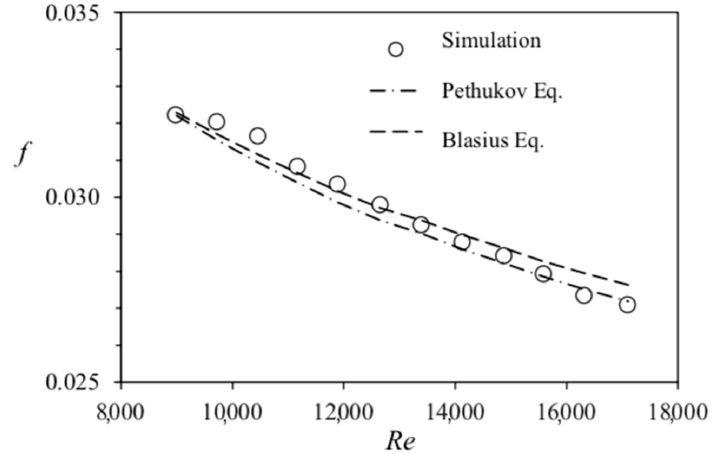
Figure 4. Friction factor validation for plain tube.